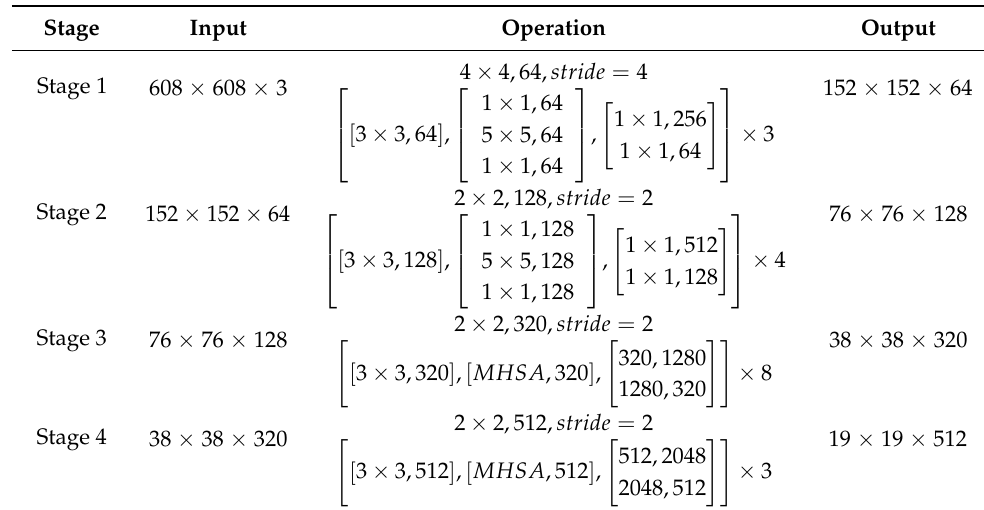
Table 3. Model configurations for the backbone network of our